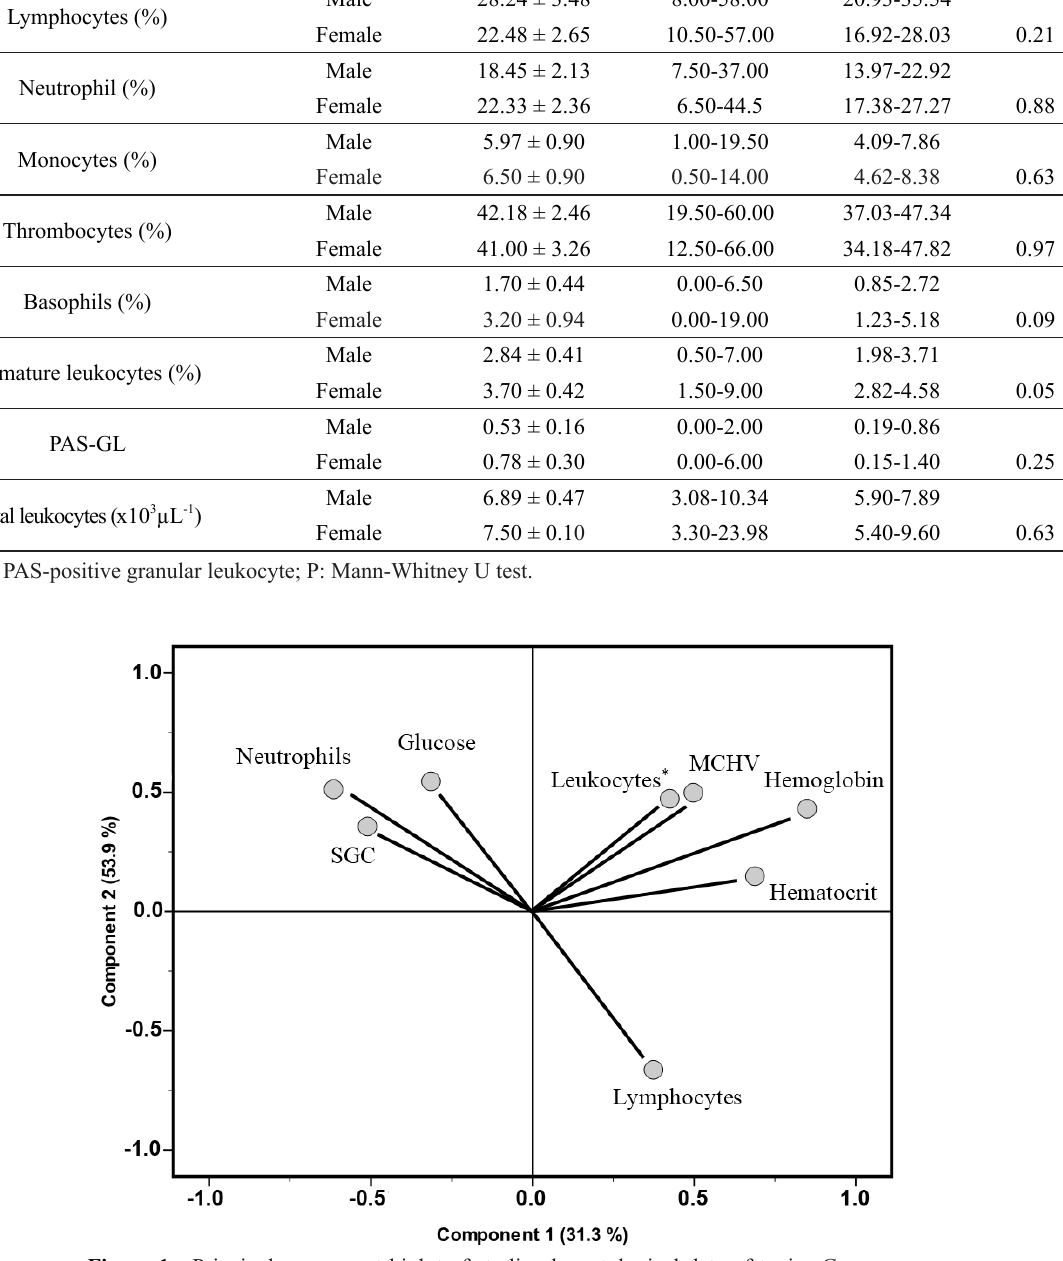
Figure 1 - Principal component biplot of starling hematological data of tuvira Gymnotus inaequilabiatus from Brazilian Pantanal, Brazil. MCHV: mean corpuscular hemoglobin concentration; PAS-GL: PAS-positive granular leukocyte; * total